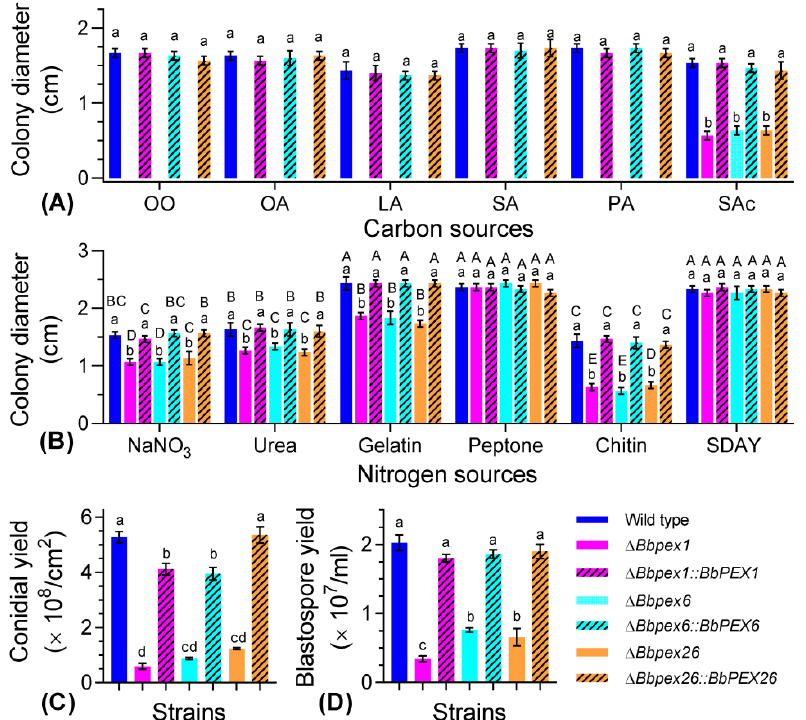
Figure 3. Fungal vegetative growth and development. Considering the minerals in CZA, various carbon ( A ) and nitrogen ( B ) sources were assayed. Carbon sources included olive oil (OO), oleic acid (OA), linoleic acid (LA), stearic acid (SA), palmitic acid (PA), and sodium acetate (SAc). SDAY was used as the control nutrient-rich medium. After a 7-d incubation at 25 °C, the colony diameter was examined. ( C ) Conidial production on plates. Fungal strains were inoculated on SDAY plates and cultured at 25 °C. The conidial yield was examined at 8 days post incubation. ( D ) Blastospore formation under submerged conditions. Fungal strains were cultured in SDB at 25 °C with aeration. Blastospore yield was quantified at 3 days post incubation. The lowercase letters indicate a significant difference in the indicated phenotype among different strains, while the uppercase letters indicate a significant difference among different nitrogen sources in the indicated strain (Tukey’s HSD: p < 0.05). Error bars: standard deviation.